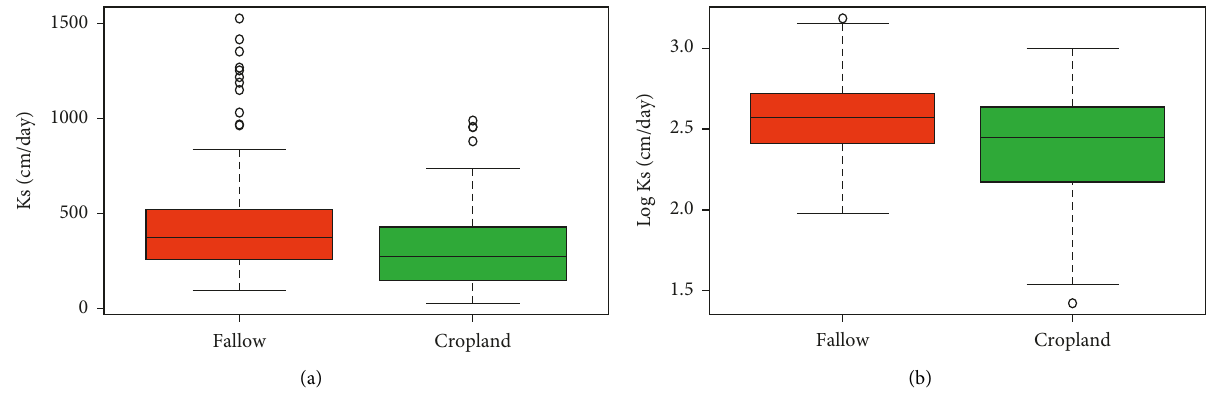
Figure 6: Boxplots of K s (a) and Log K s (b) in cropland and fallow